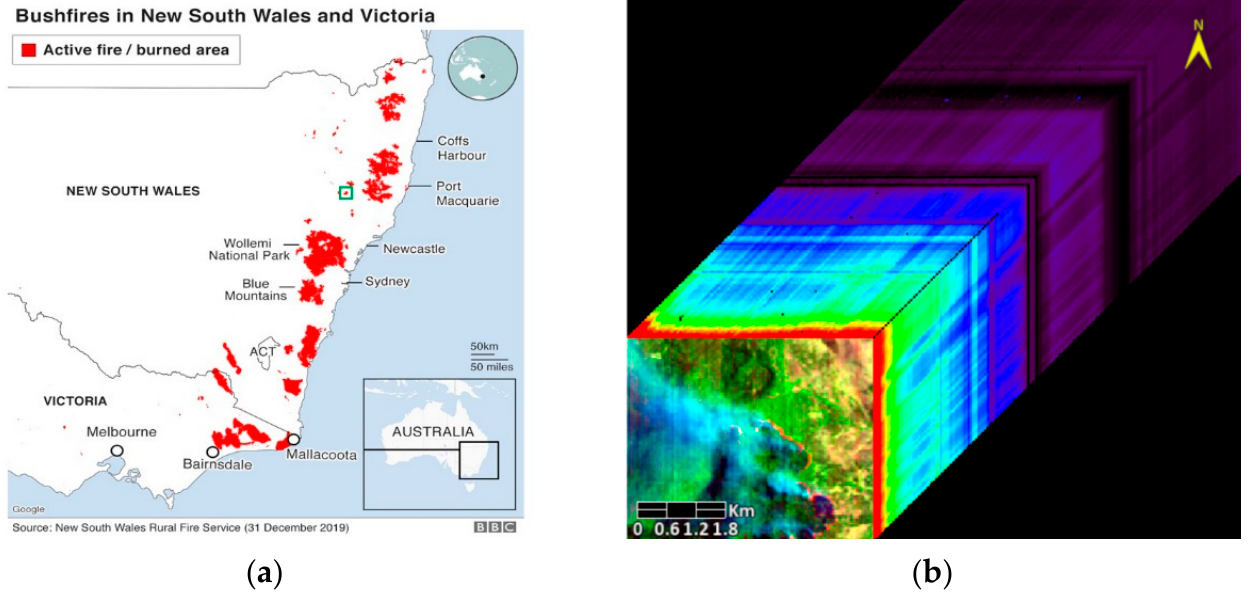
Figure 1. ( a ) Active fire/burned area map [25] for bushfires in New South Wales and Victoria on 31 December 2019. The green square in the map corresponds to Precursore IperSpettrale della Missione Applicativa (PRISMA) imaged area; ( b ) PRISMA subarea hypercube acquired on 27 December 2019. Red, Green, Blue (RGB), false color band composition with central wavelengths located at 1646.9205 nm, 8,548,984 nm and 579.1278 nm shows a derived fire front extension of about 5 km.